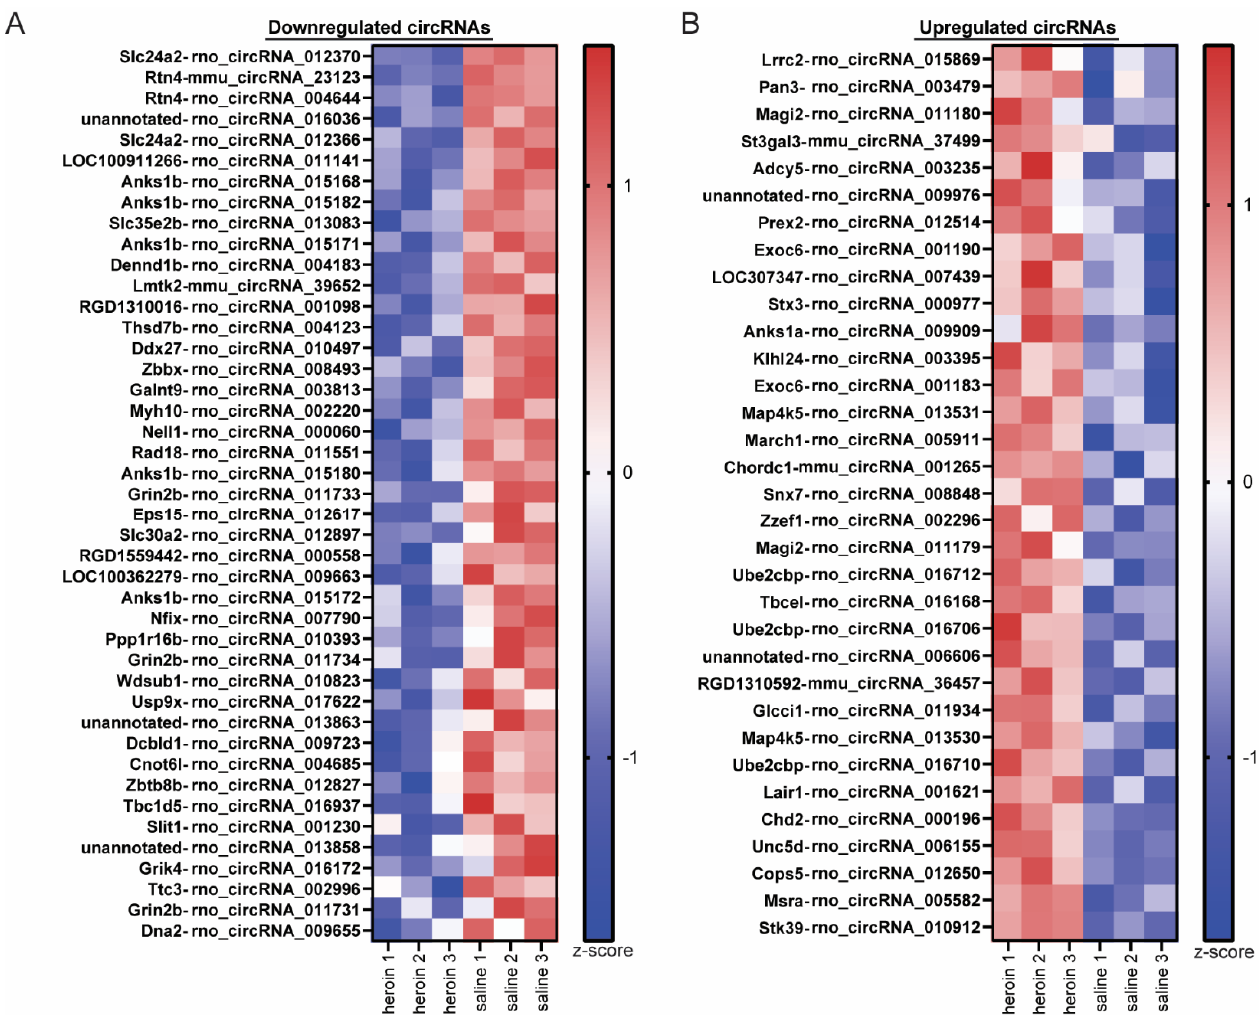
Figure 3. Heroin regulates OFC circRNA expression in male rats. Heatmap of downregulated ( A ) and upregulated ( B ) circRNAs in the OFC of male rats after 10 days of heroin self-administration. Z-scores of normalized intensities were used to create the heatmap. Displayed are the official circRNA names as well as the linear gene from which each circRNA is derived.